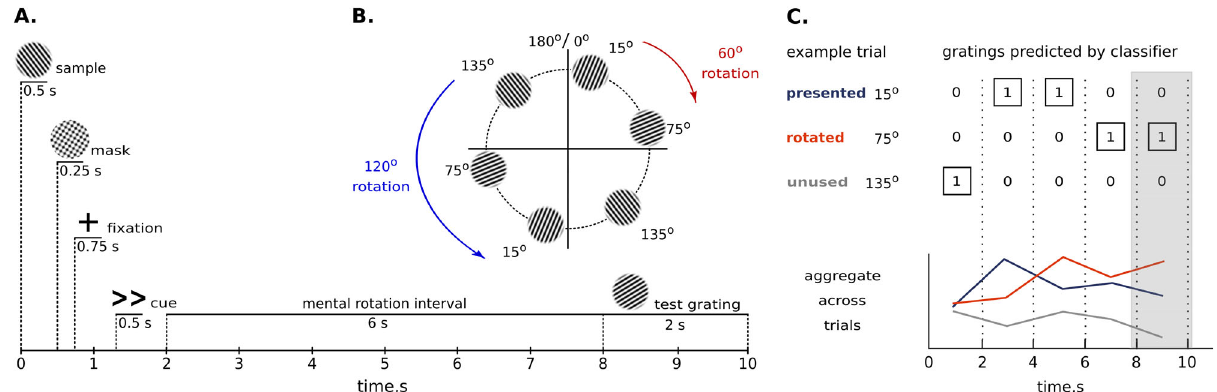
Fig. 1 Experimental methods. A On each trial, participants viewed a sample grating and then had 6 seconds to rotate it 60° (<, >) or 120° ( ≪ , ≫ ) to the left or to the right. After the mental rotation interval, participants had 2 seconds to report whether a probe grating was tilted clockwise or counterclockwise compared to the mentally rotated grating. B We used a set of three stimuli, 15°, 75°, and 135° oriented gratings. As a result of the mental rotation, each stimulus could be turned into one of the other two stimuli. For example, rotation of a 15° grating (red arrow) for 60° clockwise results in a 75° grating or rotation of a 135° grating (blue arrow) 120° counterclockwise results in a 15° grating. C This panel shows classi fi ers ’ decisions in an example trial, in which a 15° grating was rotated into a 75° grating. We aggregated results across trials by counting how often classi fi ers predicted the presented orientation, the rotated orientation, and the unused orientation. The shaded area denotes the time interval chosen for the in-depth analysis (measurements at 8 and 10